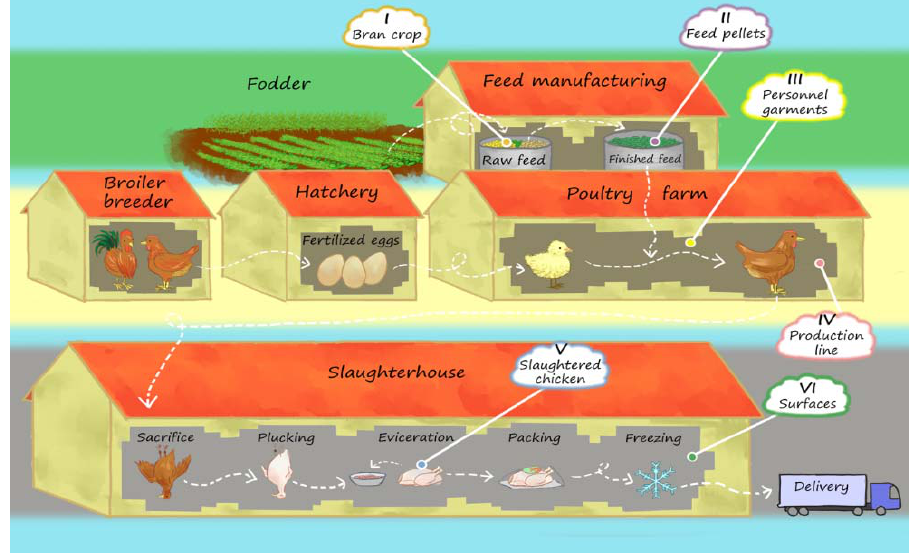
Figure 1. Schematic representation of the chicken meat production facility where the microbiological samples were taken. The sample types (I–VI) are pointed out in the corresponding production stages. The scheme was created by the illustrator Florence Gutzwiller (IG: @spideryscrawl).